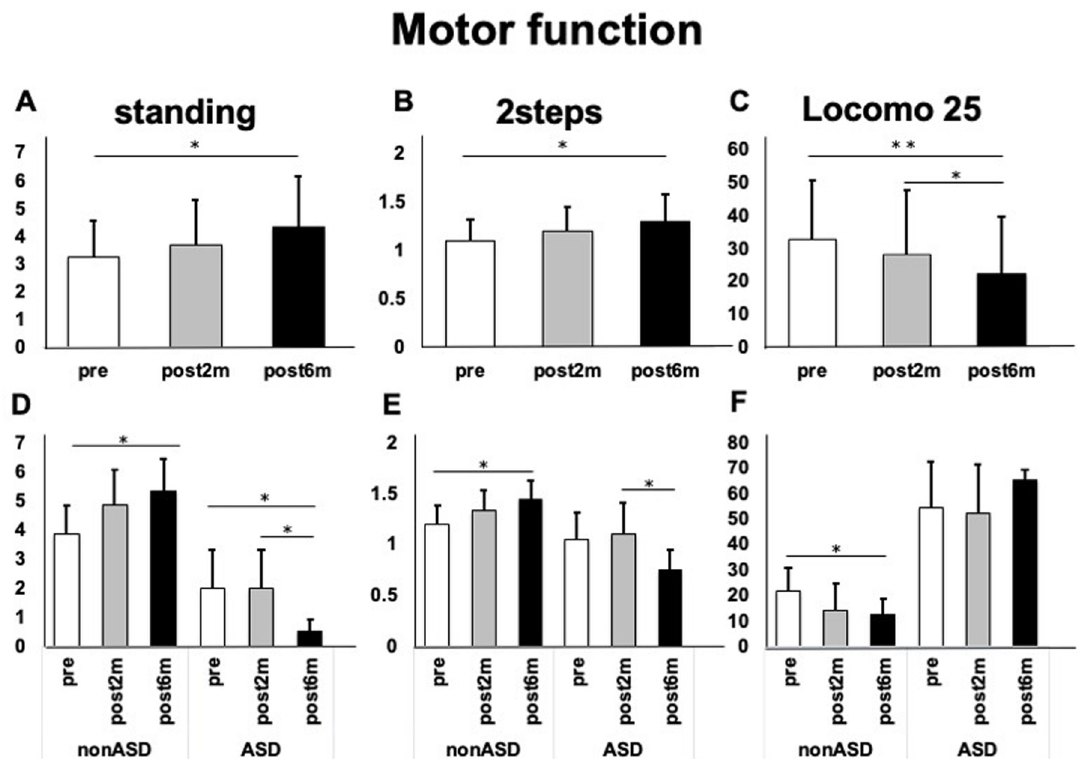
Fig 3. Motor function before and after intervention. A) Changes in the standing test in all patients. B) Changes in the two-step test in all patients. C) Changes in the locomotor 25 test in all patients. D) Changes in the standing test in the ASD and non-ASD groups. E) Changes in the two-step test in the ASD and non-ASD groups. F) Changes in the locomotor 25 test in the ASD and non-ASD groups ( * p <